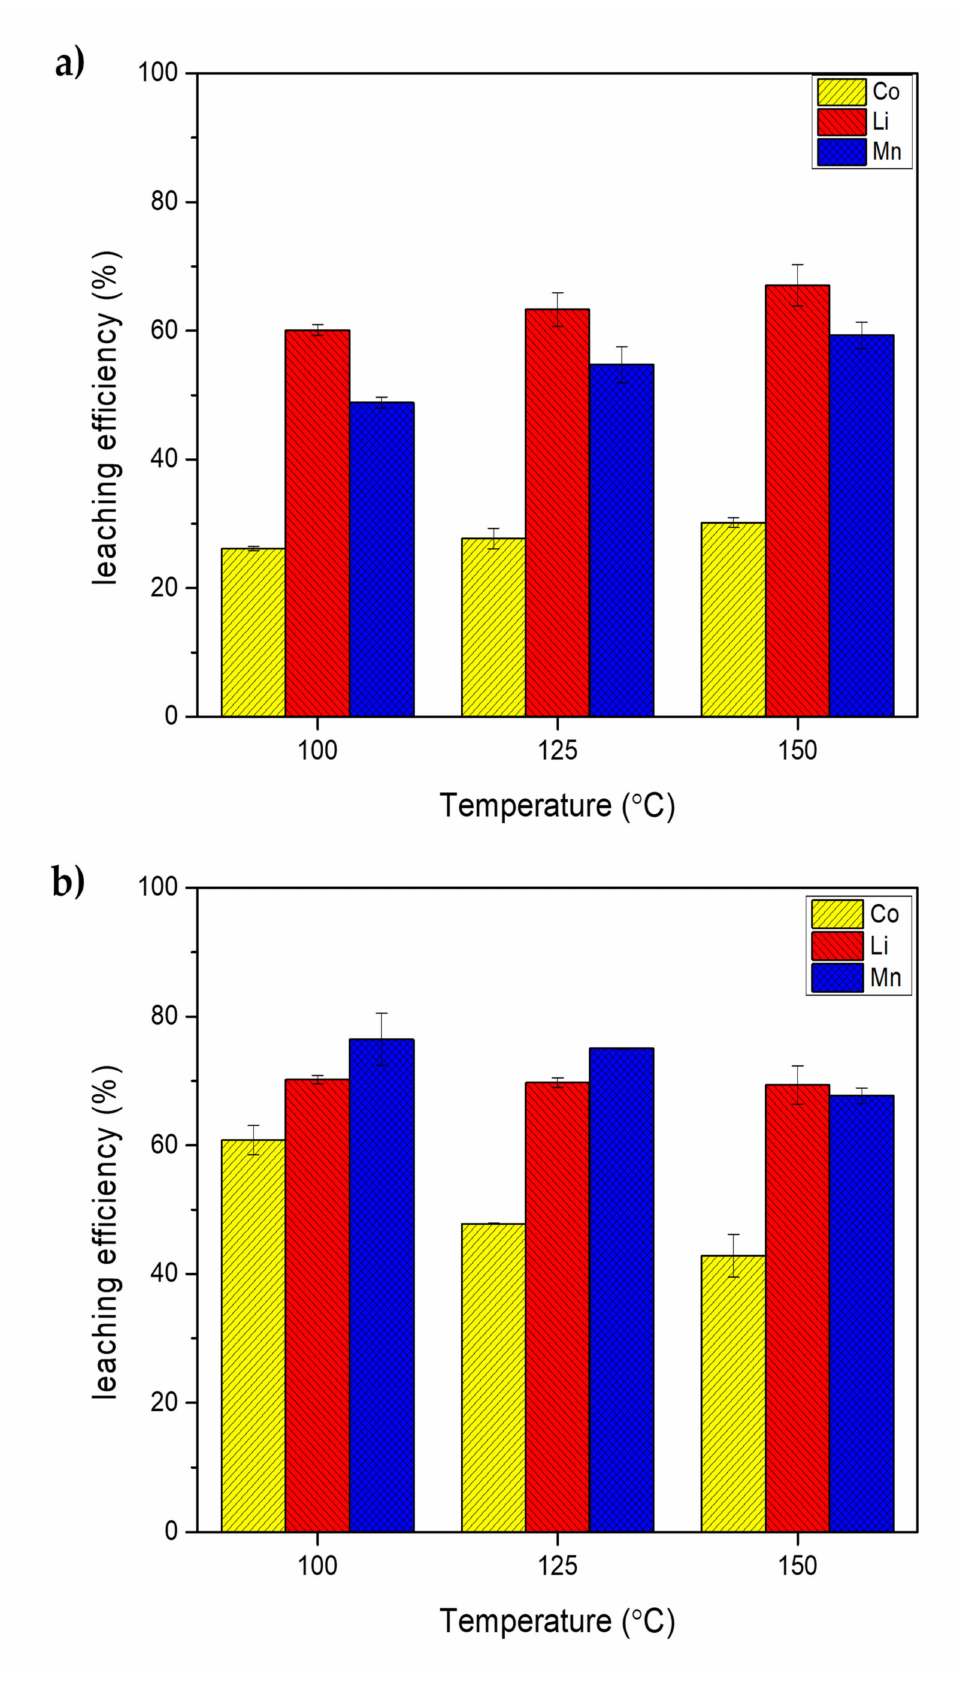
Figure 2. E ff ect of temperature on SWE at S / L of 10 g / L for 30 min using 0.1 M of ( a ) HCl and ( b ) ascorbic